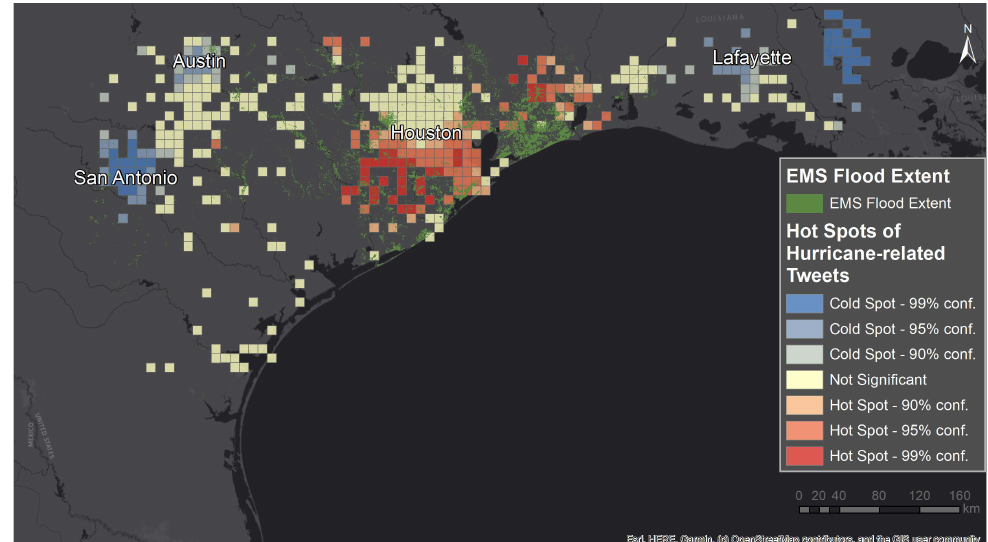
Figure 9. Hurricane hot and cold spots obtained using GLDA V2 compared to COPERNICUS Emergency Management Service (EMS) [45] mapping data depicting flooded areas six days after the